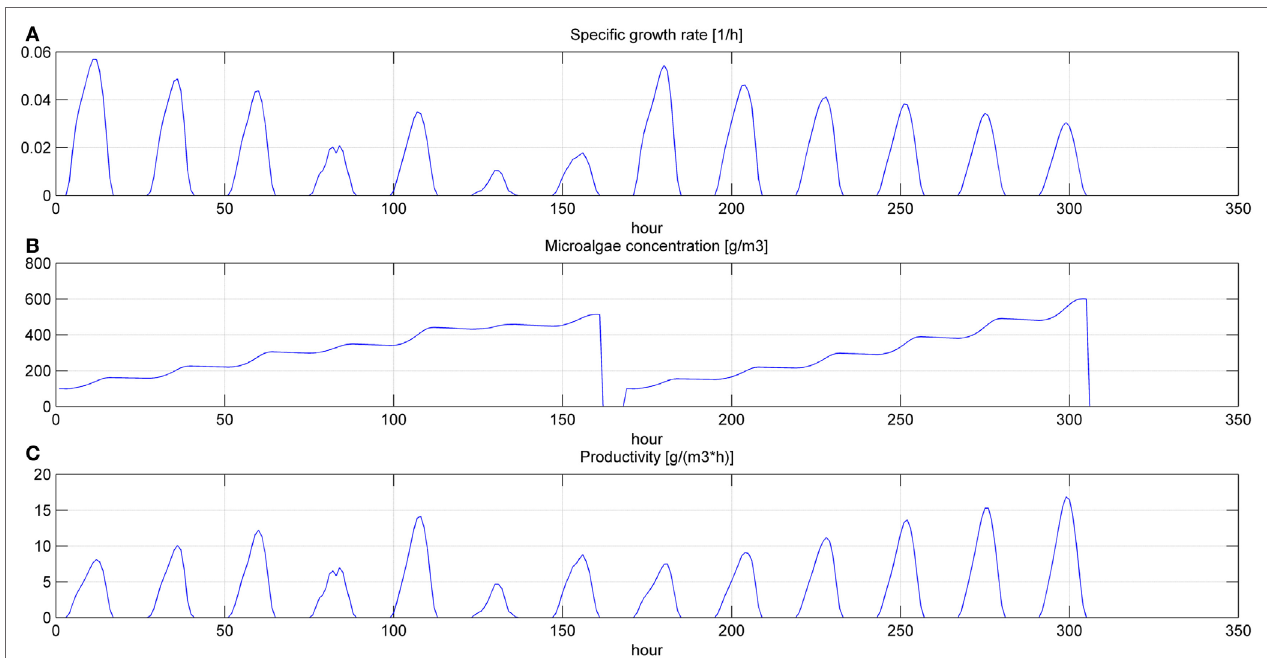
FigUre 7 | specific growth rate (a), microalgae concentration (B) and microalgae volumetric productivity (c) in the open pond during two consequent batch cultivations (simulation time equal to two hrTs)